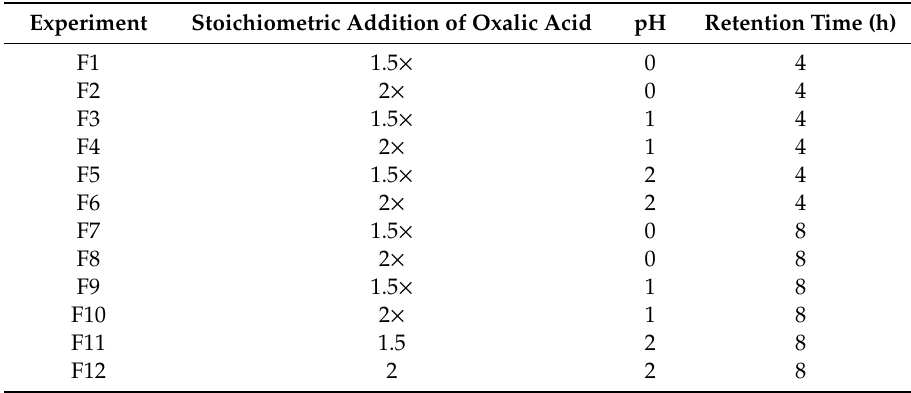
Table 2. Parameters of the executed experiments.